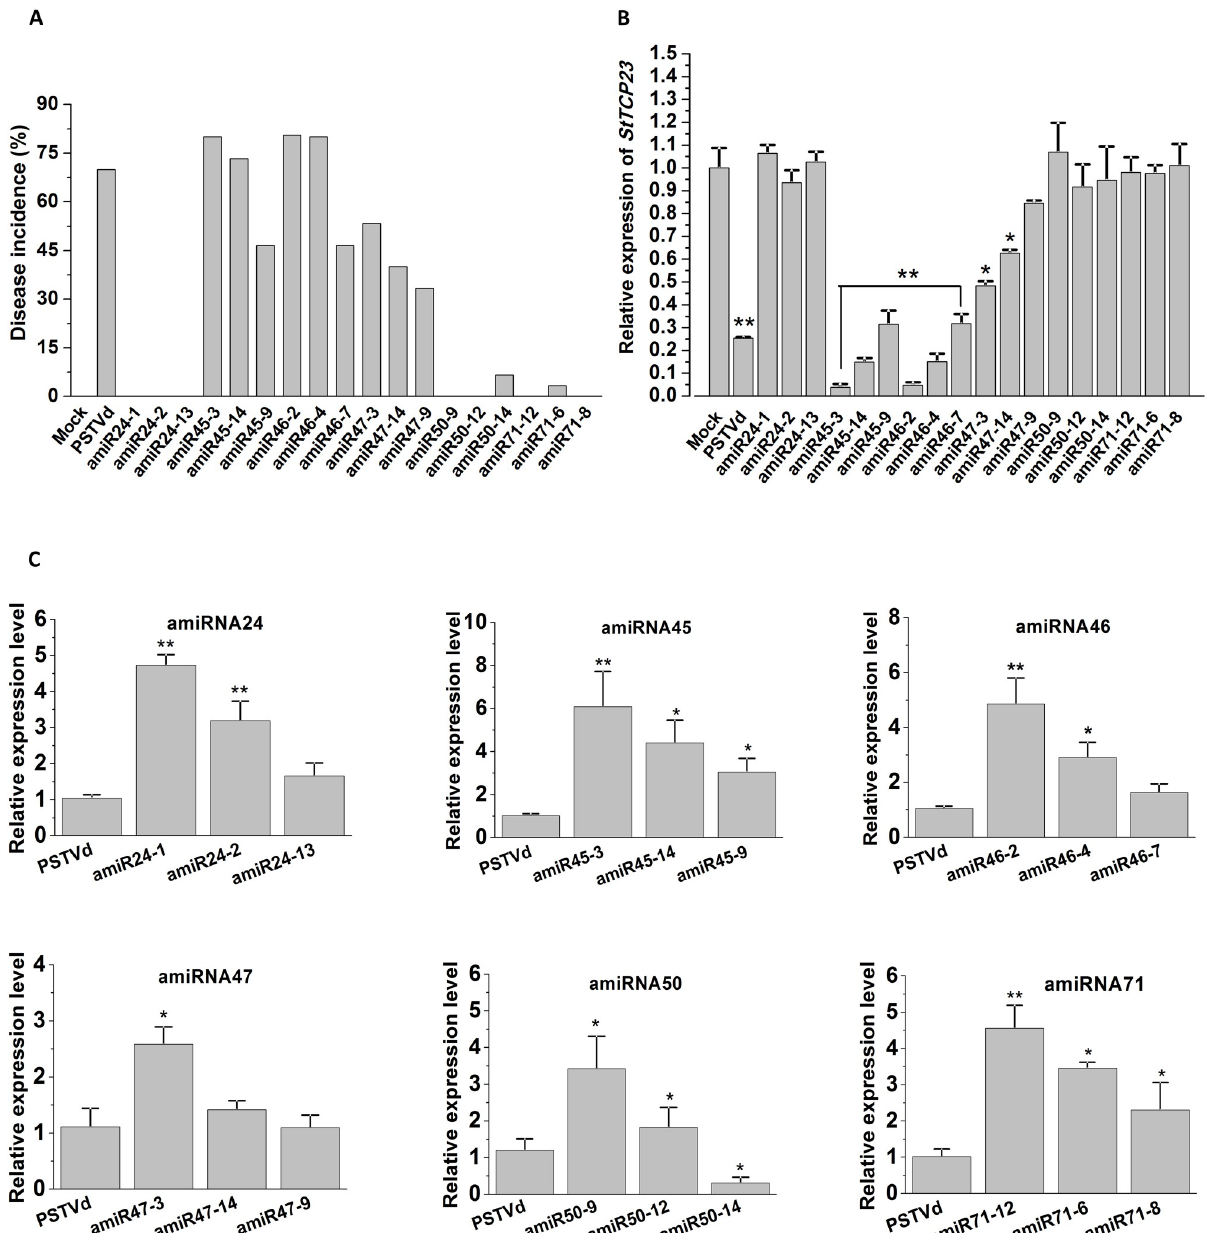
Fig 6. Variation in amiRNA and StTCP23 expression among different transgenic potato lines expressing amiRNAs. (A) Disease severity index of amiRNA transgenic lines. Mean values (n = 18) are shown. (B) RT-qPCR quantitation of PSTVd sRNA levels in transgenic lines. In each panel, the leftmost bar is a control derived from PSTVd-RG1-infected non-transgenic plants. From left to right, the remaining three bars are values from transgenic plants expressing severe, intermediate, or mild symptoms. (C) Relative StTCP23 mRNA in amiRNA transgenic lines expressing severe, medium, or mild